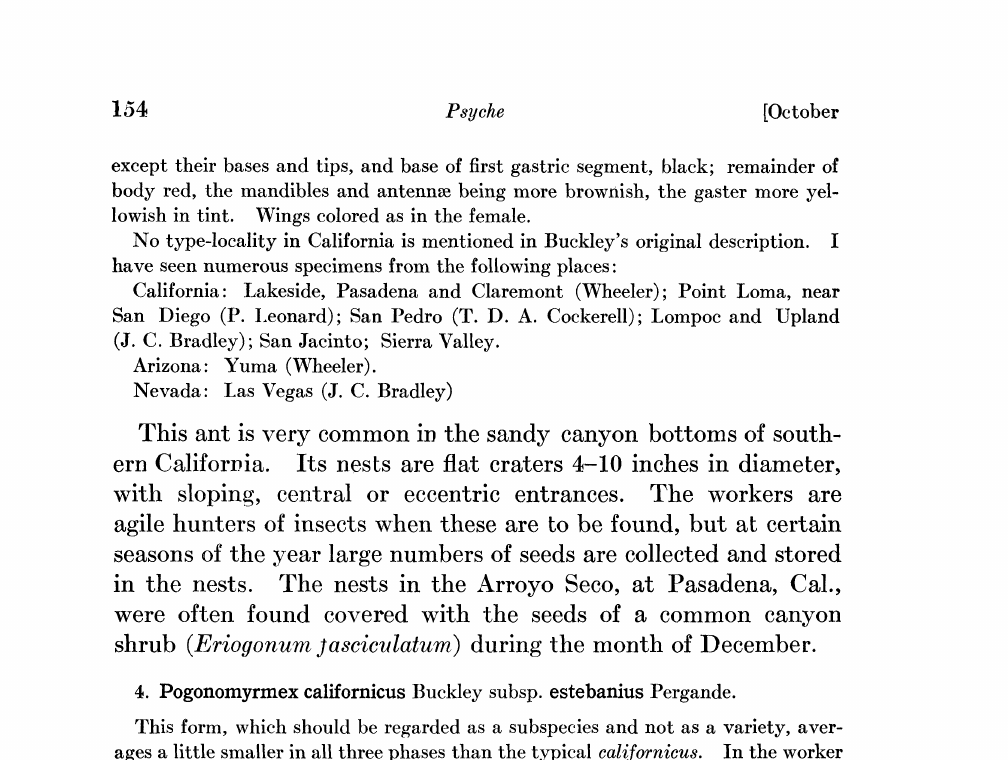
except their bases and tips, and base of first gastric segment, black; remainder of body red, the mandibles and antennm being more brownish, the gaster more yel- lowish in tint. Wings colored as in the female. No type-locality in California is mentioned in Buckley’s original description. I have seen numerous specimens from the following places: California: Lakeside, Pasadena and Claremont (Wheeler); Point Loma,